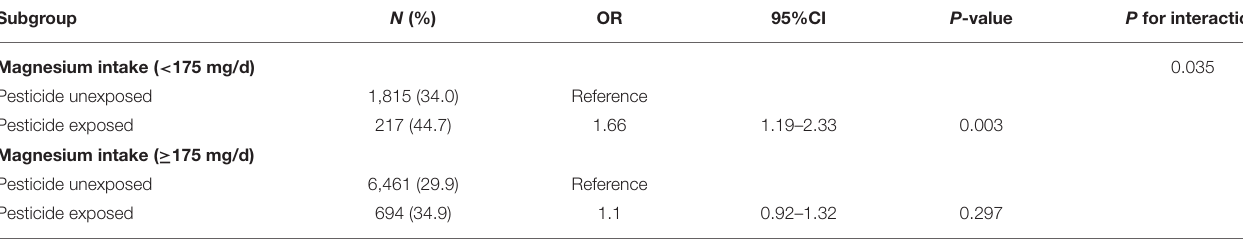
TABLE 4 | The associations between pesticide exposure in home and type 2 diabetes risk by dietary magnesium